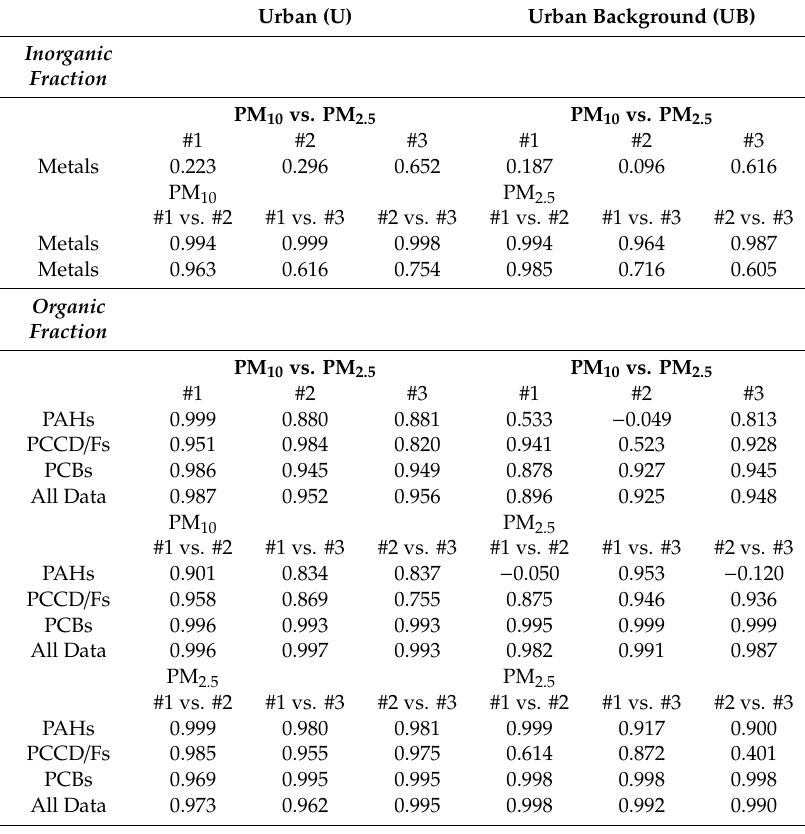
Table 4. Correlation Coe ffi cients ( r ) between PM 10 and PM 2.5 Fractions among the Compounds Investigated in the Di ff erent Sectors (#1, #2 and #3) during the Entire